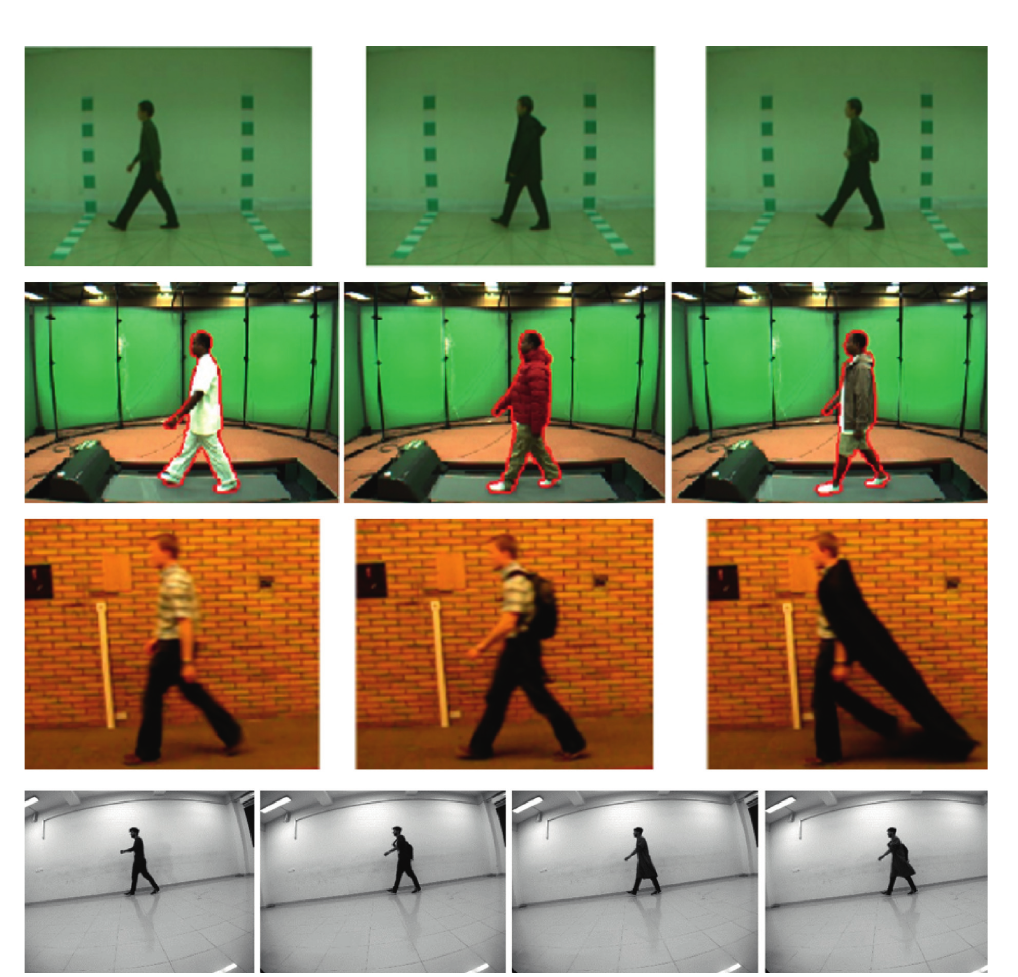
Figure 1: (Top to bottom) use cases of CASIA-B. OUISIR-B, TUM-IITKGP, and SACV